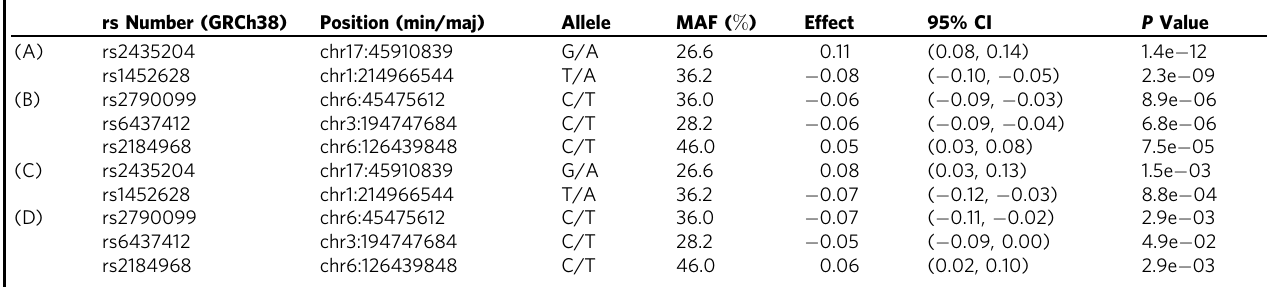
Table 4 Sequence variants associated with PAD estimated using BOLT-LMM.